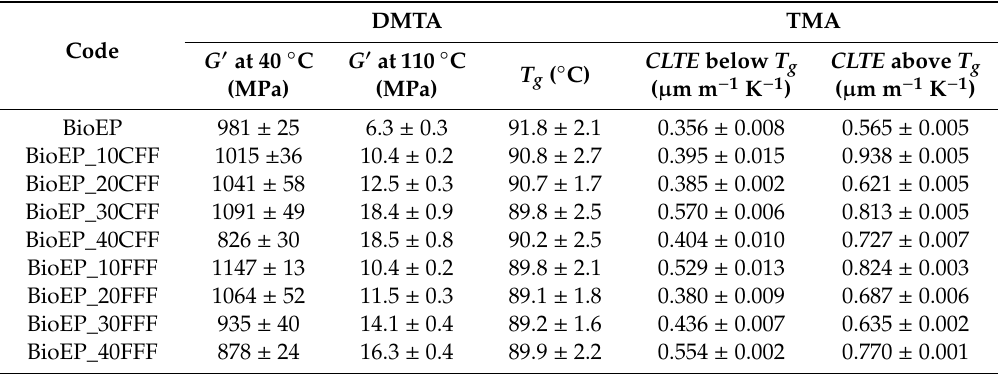
Table 3. Values of dynamic mechanical, thermal analysis (DMTA), and thermomechanical analysis (TMA) of BioEP and BioEP composites reinforced with di ff erent CFF and FFF content. DMTA TMA Code G (cid:48) at 40 ◦